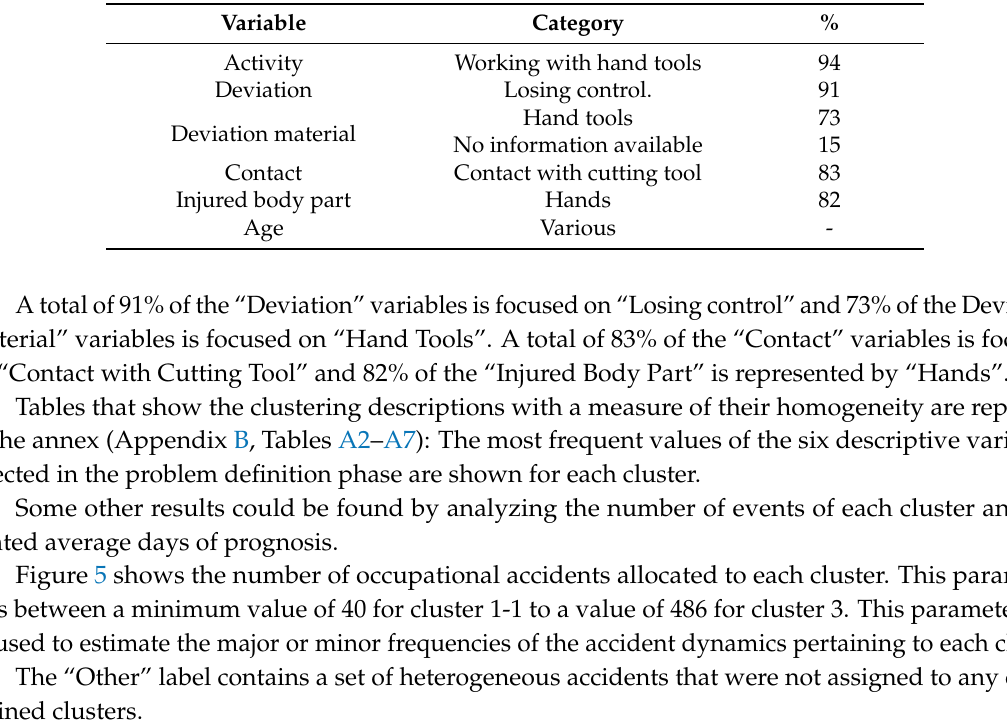
Table 4. CL3 description.